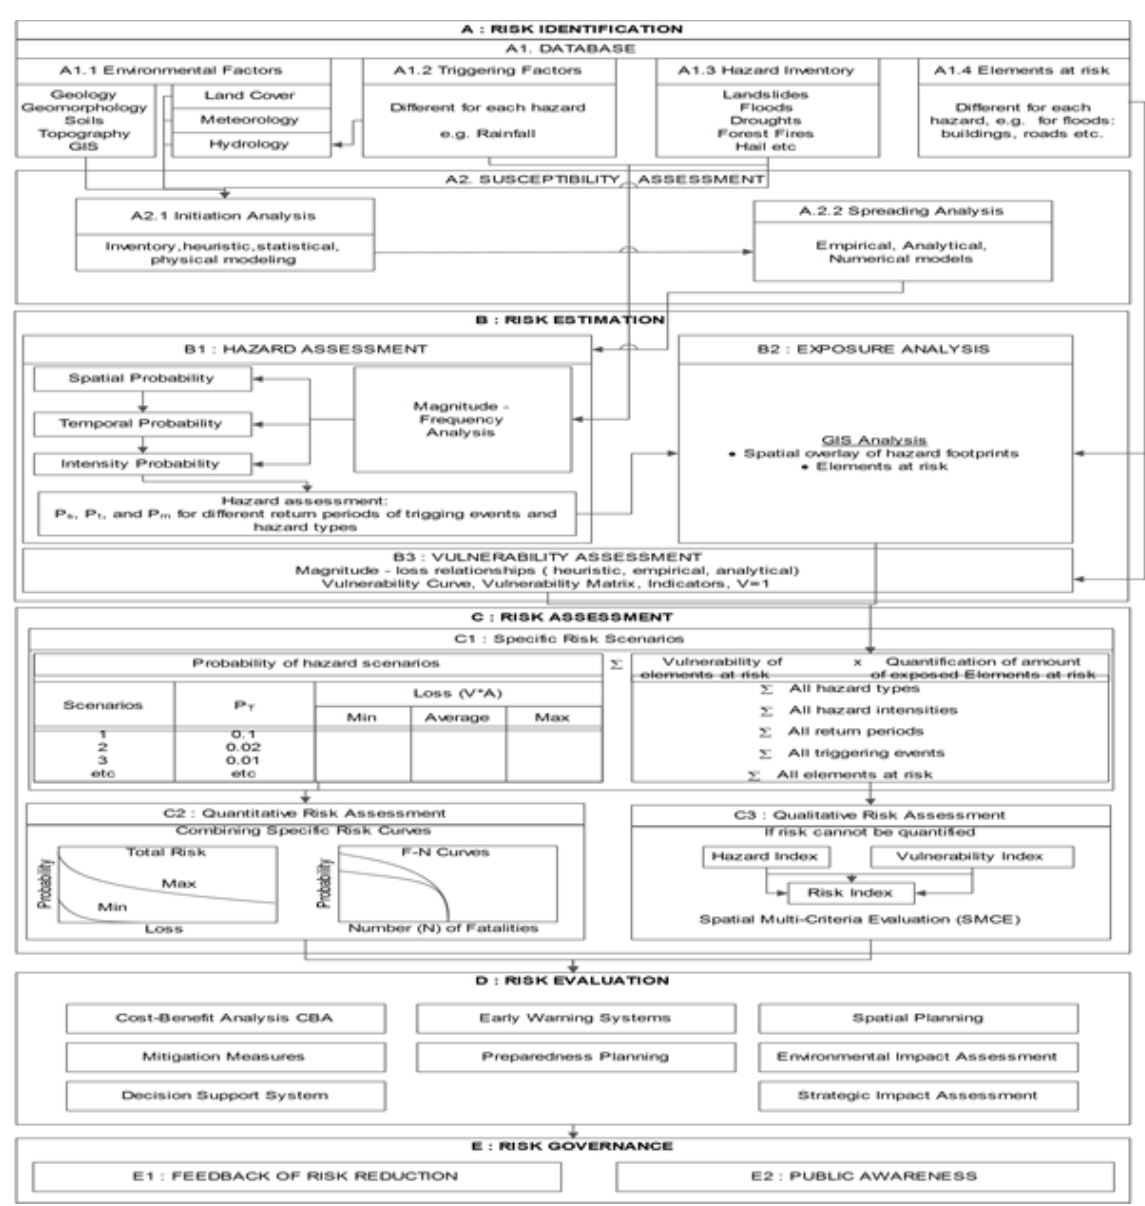
Figure 2. Flow chart of risk analysis methodological procedure (adapted from Dalezios and Eslamian,